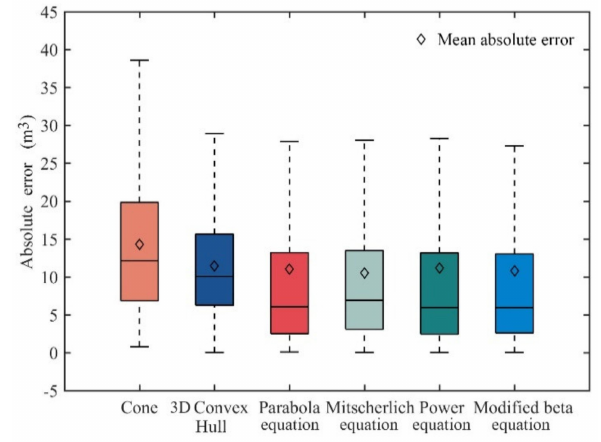
Figure 6. Comparison of crown volume prediction for the six models by absolute